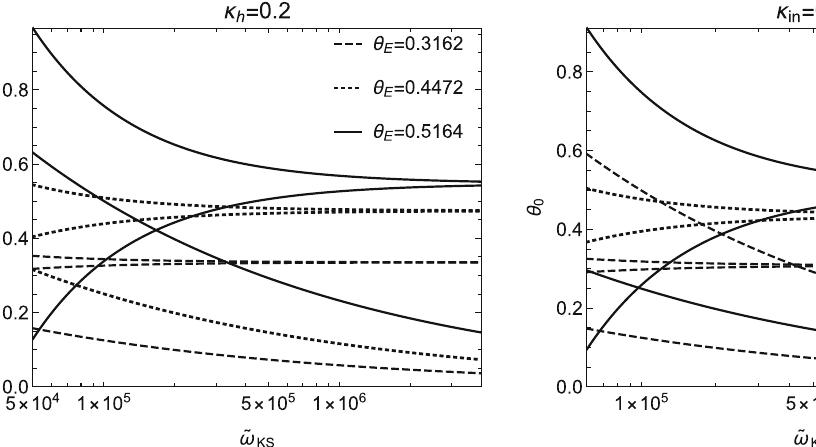
the dependence of Einstein angle ( θ 0 ) for inhomogeneous distribution of plasma with dimensionless “Hoˇrava parameter” ( ω values of θ E : 0.5164 (solid line), 0.4472 (dashed line), 0.3162 (dotted